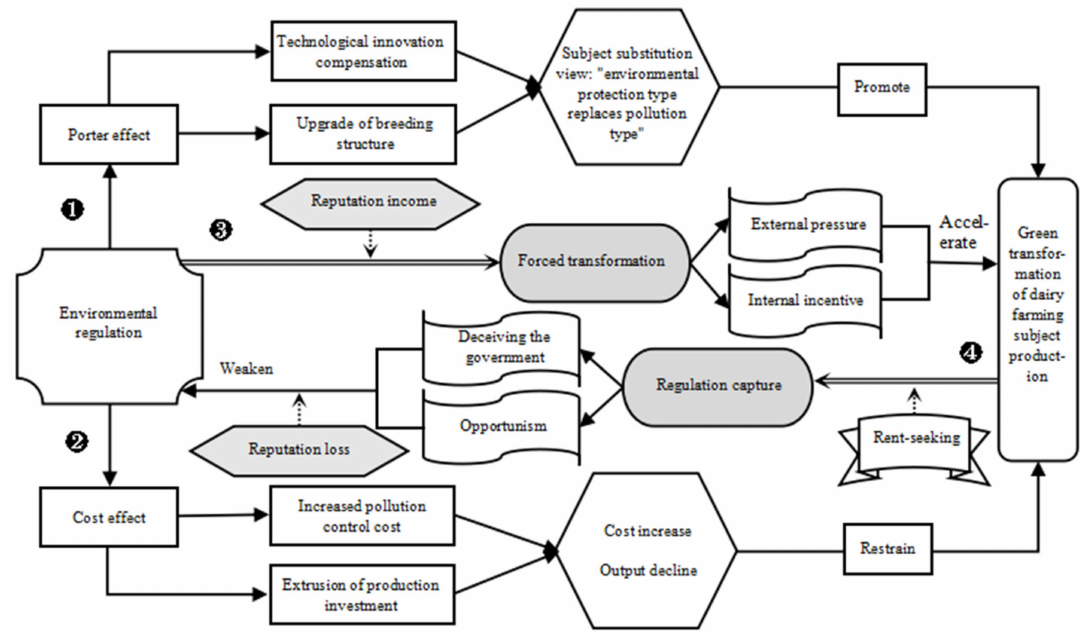
Figure 1. Interaction mechanism between environmental regulation and green transformation of dairy farming subject